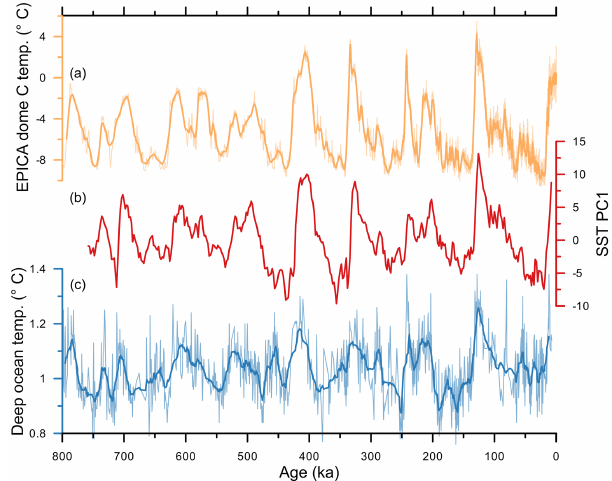
Figure 5. Temperature records. (a) Deuterium-based temperature record from EPICA Dome C in Antarctica (light yellow; Jouzel et al., 2007). The darker yellow line is a 15-point moving average. (b) The first principal component of our sea-surface temperature analysis (red). (c) Bottom water temperature derived from Mg / Ca measurements at ODP 1123 (light blue; Elderfield et al., 2012). The dark blue line is a 15-point moving average.